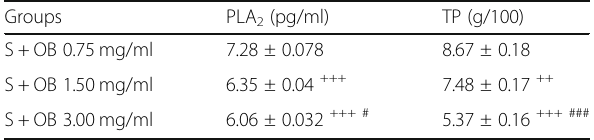
Table 3 PLA 2 and total protein (TP) values in sensitized group treated with three different concentrations of O. basilicum (S